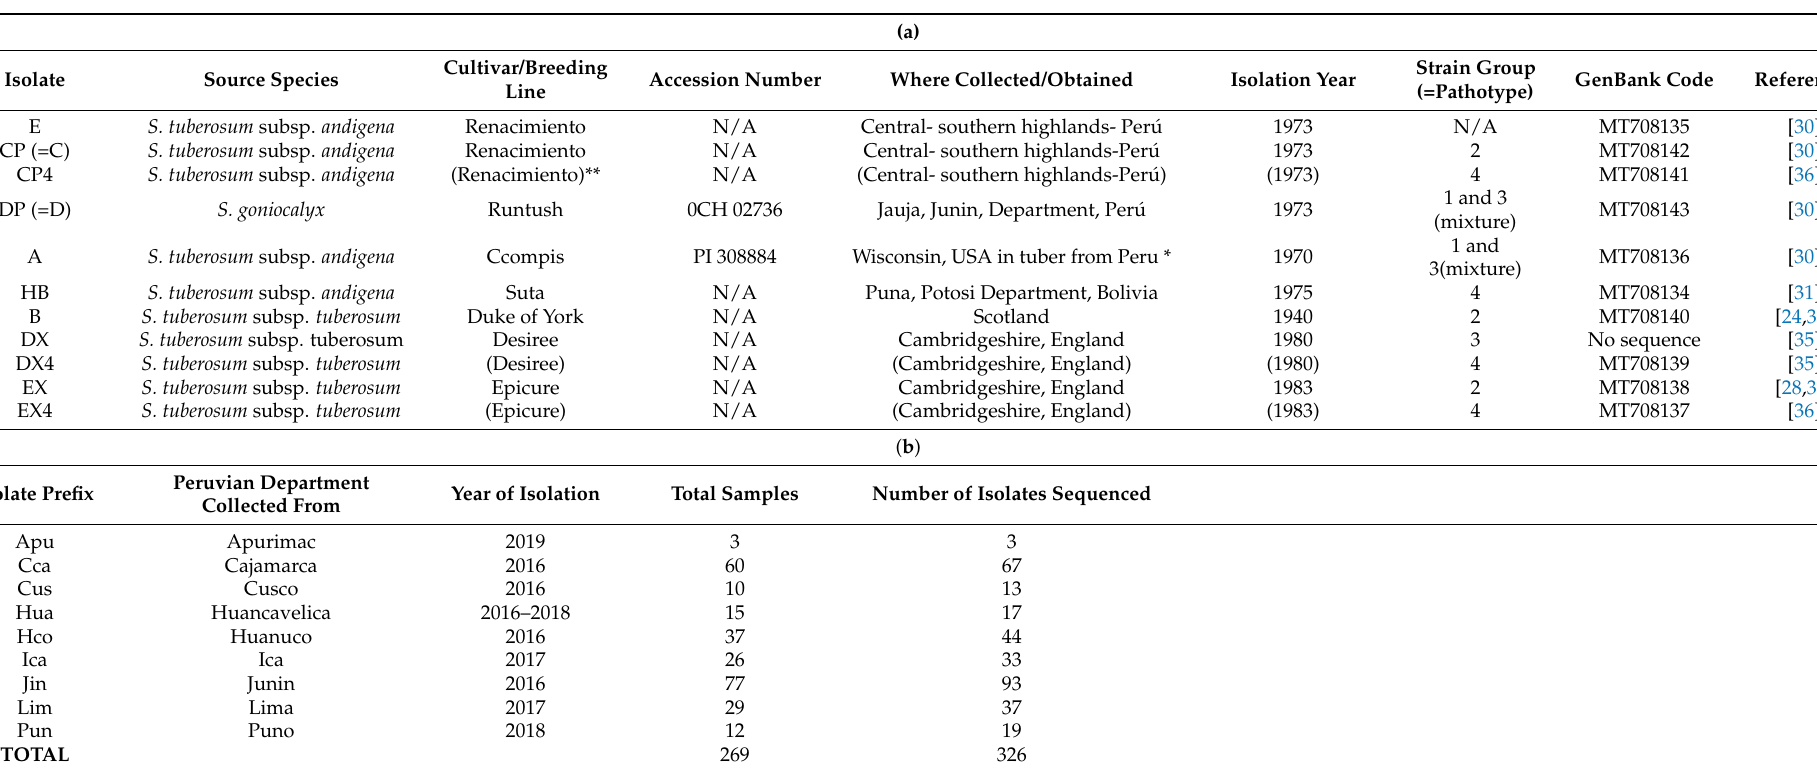
Table 1. Origins of potato virus X (PVX) isolates newly sequenced in this study. ( a ) Historical sequences collected in 1940 to 1983. ( b ) Summary of Peruvian sequences from samples collected in